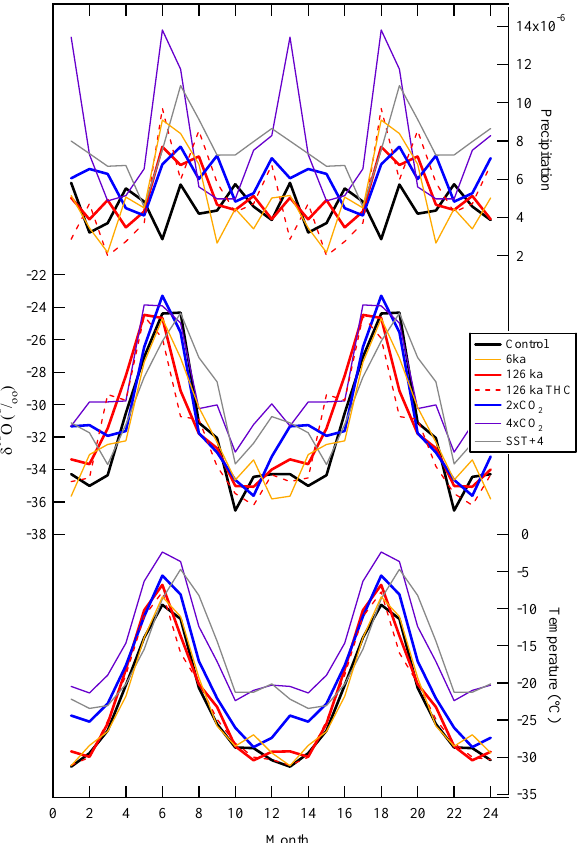
Fig. 6. Monthly seasonal cycle of temperature, precipitation and precipitation δ 18 O simulated by LMDZiso for different sets of boundary conditions (AMIP control, 6ka, 126ka, +4 ◦ C SST, 2 × and 4x × CO 2 concentrations) prescribed using the IPSL-CM4 sea surface conditions (see Table 1). For readability, the seasonal cycle has been repeated over 2 years (24